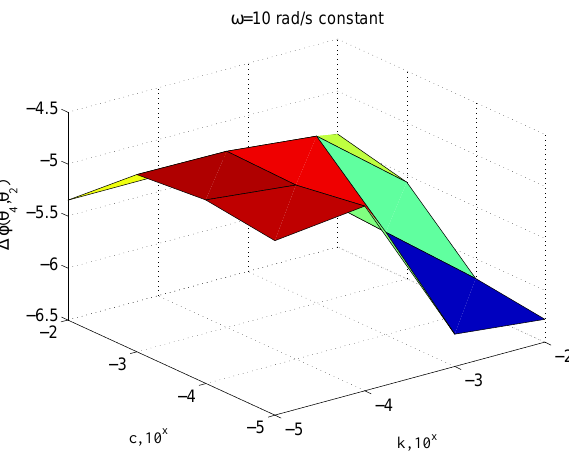
Figure 18. Dependency of the phase delay ∆ φ ( θ 4 , θ 2 ) with respect to c and k for an assigned value of ω